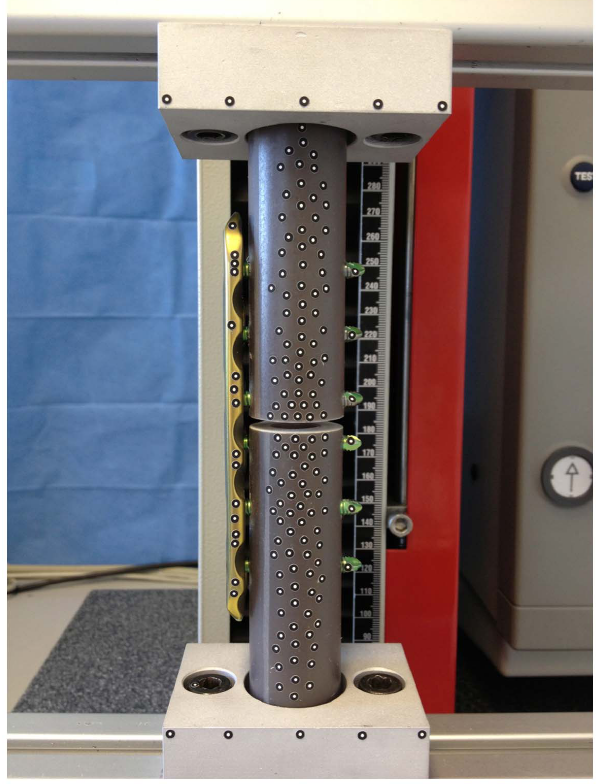
Figure 4. Specimens had a diameter of 27 mm, a wall thickness of 7 mm, a length of 193 mm and a Young’s modulus of 16.7 GPa. Passive markers were attached to both cylinders and the LCP to perform the measurement with the optical motion analysis system.